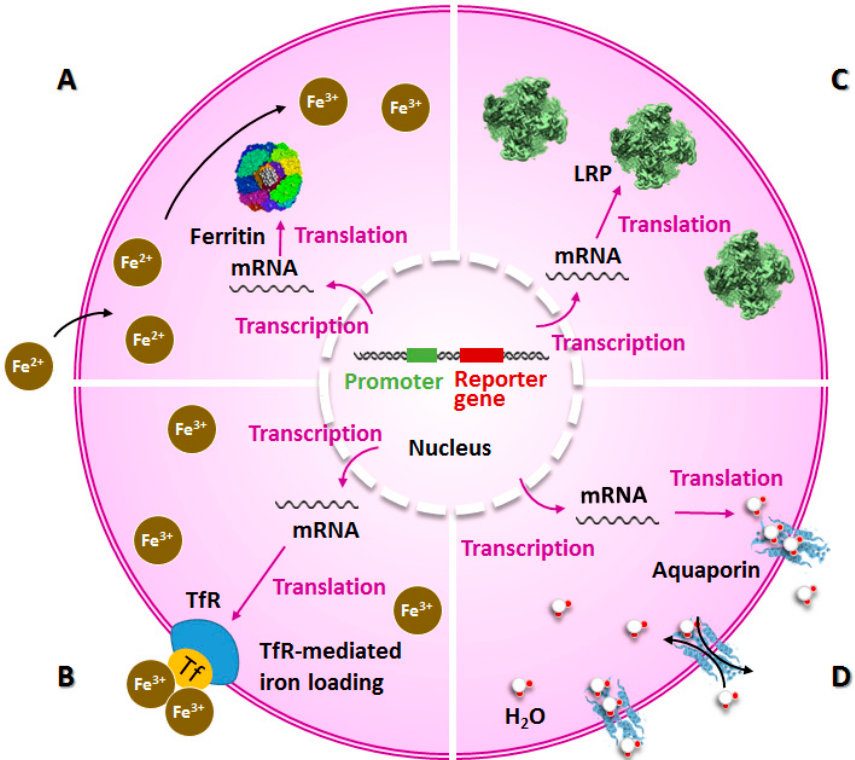
Figure 1. The principle of MRI reporter genes commonly used in brain imaging. ( A ) The expression of ferritin will cause intracellular iron particles to aggregate, resulting in a decrease in the T2 signal in MRI images. ( B ) The expression of TfR increases the iron uptake of cells and shows low signal intensity on T2 images of MRI. ( C ) LRP has a high chemical exchange rate and can be used in CEST MRI. ( D ) Aquaporin can increase water diffusivity and produce contrast in diffusion-weighted MRI. PET imaging of reporter gene expression utilizes reporter gene imaging agents that are labeled by positron radionuclides. Currently, there are three types of commonly used radionuclide reporter gene imaging systems based on enzymes, receptors, and transporters, as shown in Figure 2 [6,25]. The most common reporter genes of enzymes are herpes simplex virus 1 thymine kinase (HSV1-tk) [9] and human ∆ -mitochondrial thymine kinase type 2 (h ∆ tk2) [26]. The most common reporter genes are human somatostatin receptor type 2 (hSSTR2) [27] and dopamine D2 receptor (D2R) [28]. The most common reporter genes of transporters are human sodium–iodide symporter (hNIS) [29] and human nore- pinephrine transporter (hNET)